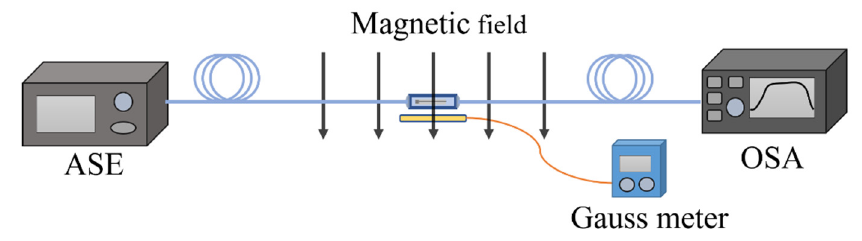
Figure 7. Magnetic field intensity testing device.